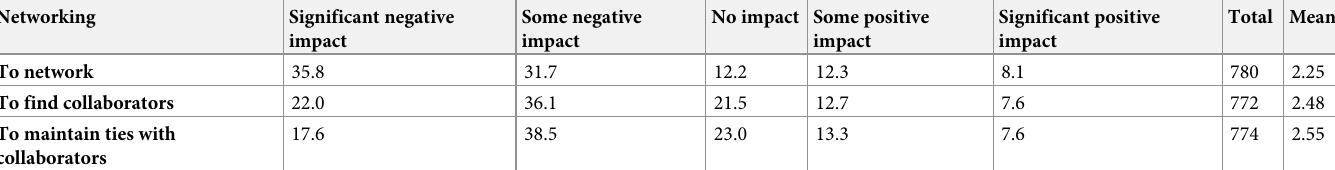
Table 12. How has the pandemic affected your ability to do the following? (%). Networking